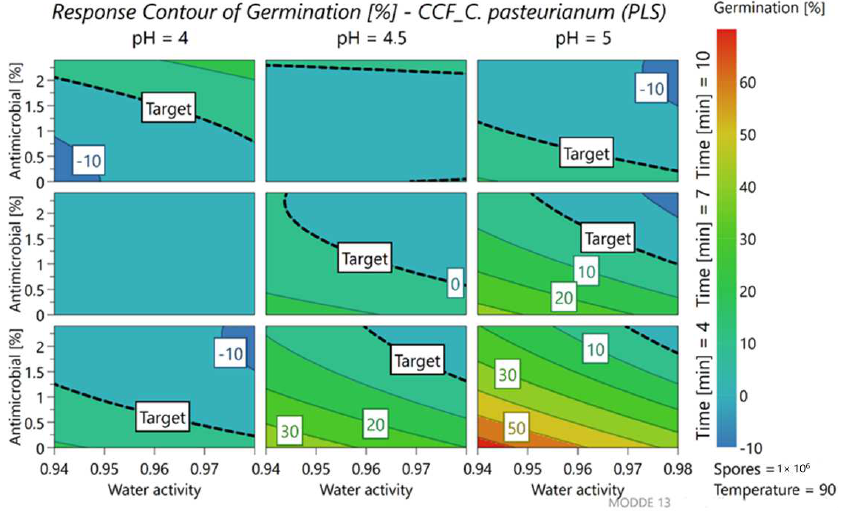
Figure 6. Contour plot representing the percent of germination of C. pasteurianum LMG 3285, at different levels of different levels of parameters.